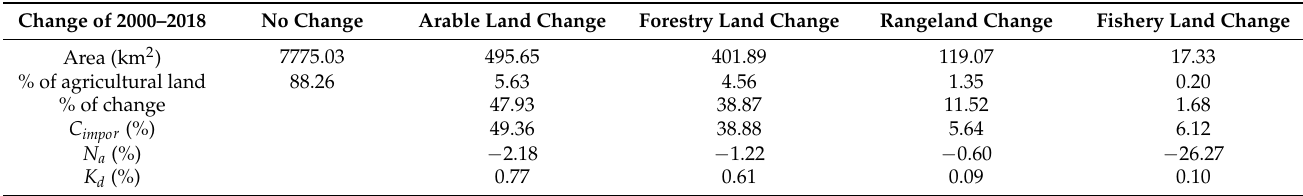
Table 4. Agricultural land change between 2000 and